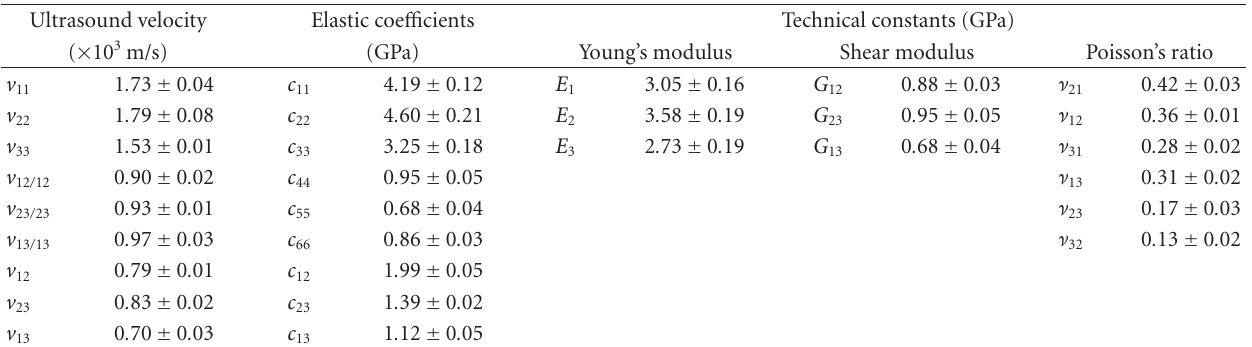
Table 1: Ultrasound velocity and elastic property of the condyle (mean ± SD, n =